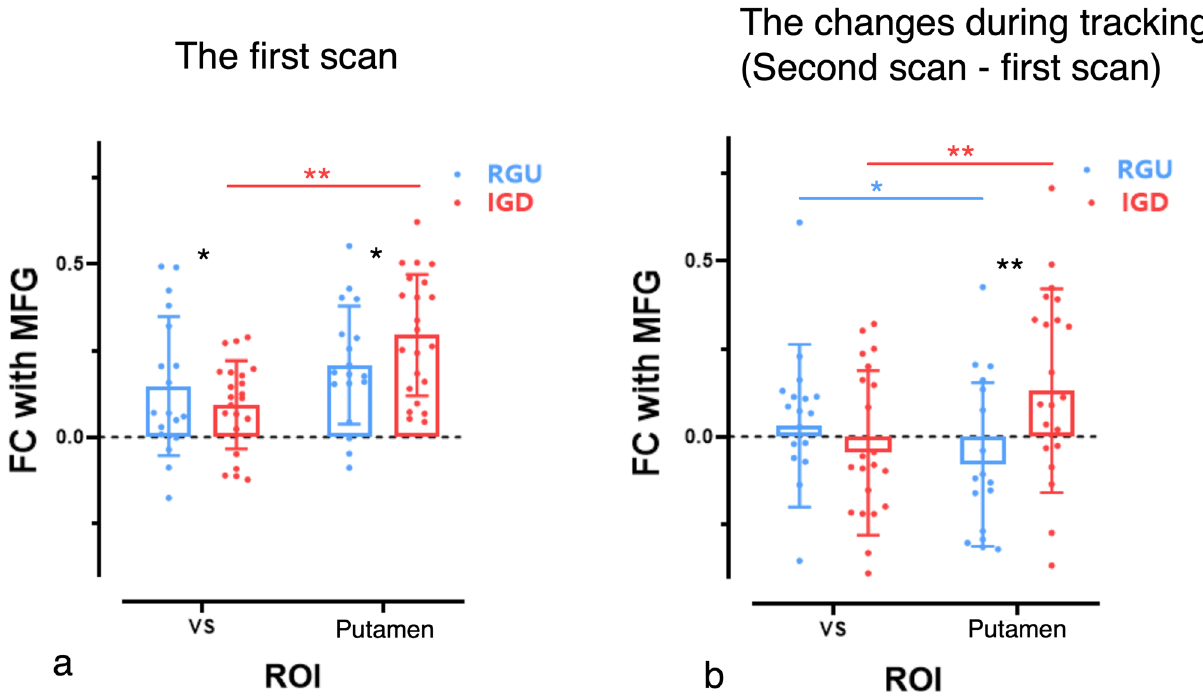
Fig. 4 The VS-to-putamen involvement in longitudinal data. a The functional connectivity strength between ventral striatum/putamen and MFG in IGD and RGU groups in the fi rst scan. b The functional connectivity strength changes between ventral striatum/putamen and MFG in IGD and RGU groups in the following scan relative to the fi rst scan. * p < 0.05; ** p < 0.01; *** p <